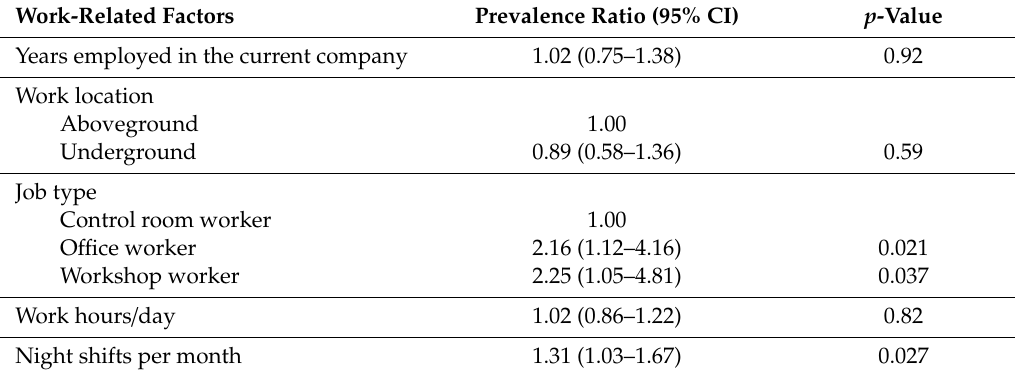
Table 3. Work-related factors associated with vitamin D deficiency; results of multivariate